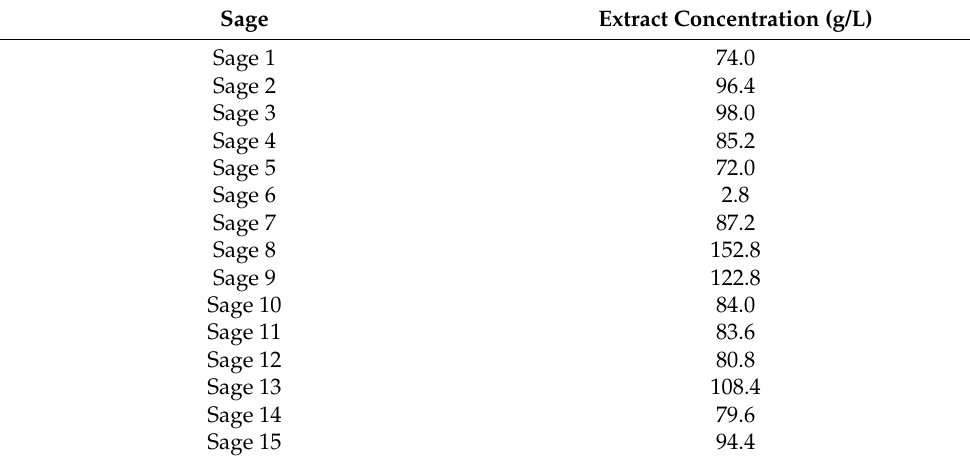
Table A1. Final concentration (g/L) in the ethanolic sage extracts.